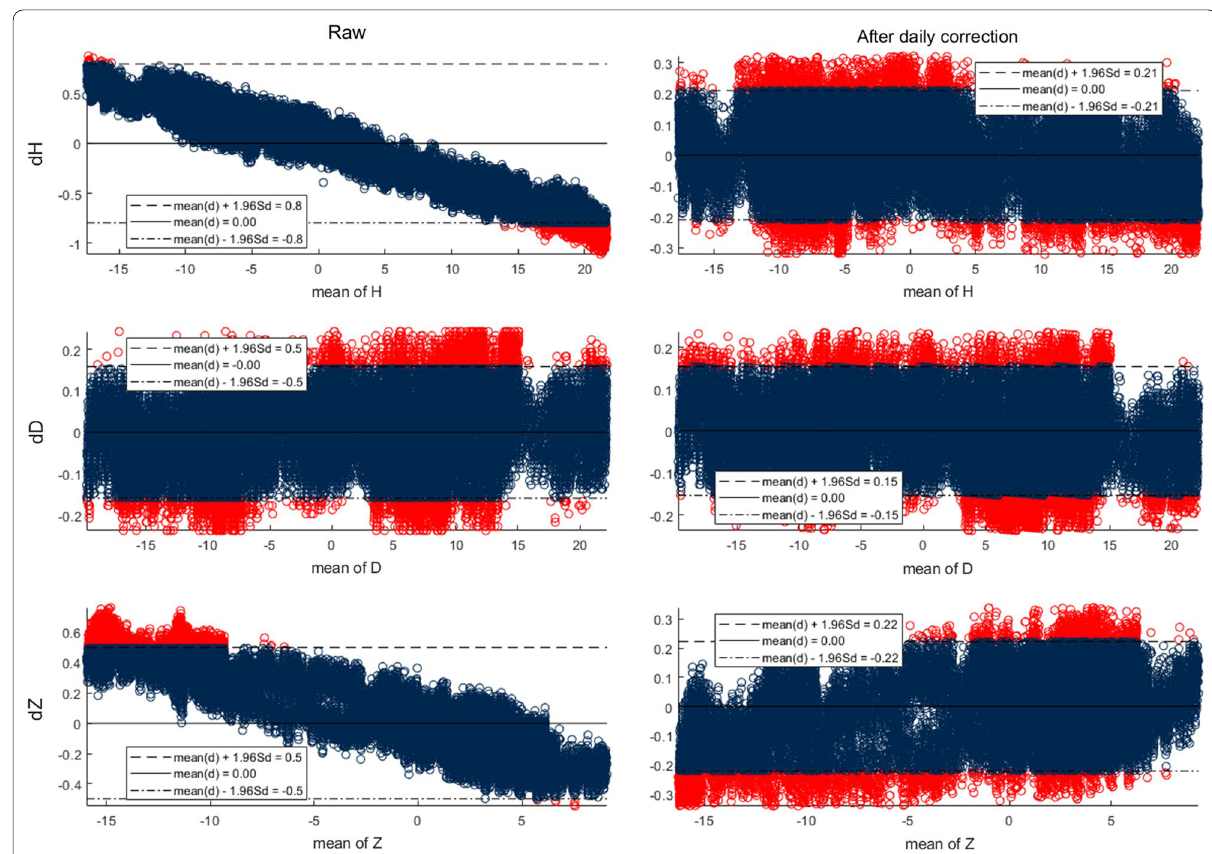
Fig. 7 Bland–Altman (B–A) plots of the comparative geomagnetic vector observations on March 30, 2020, at